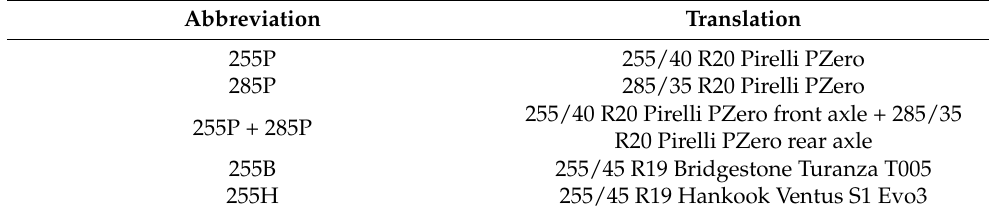
Table A1. List of abbreviations tire combinations.